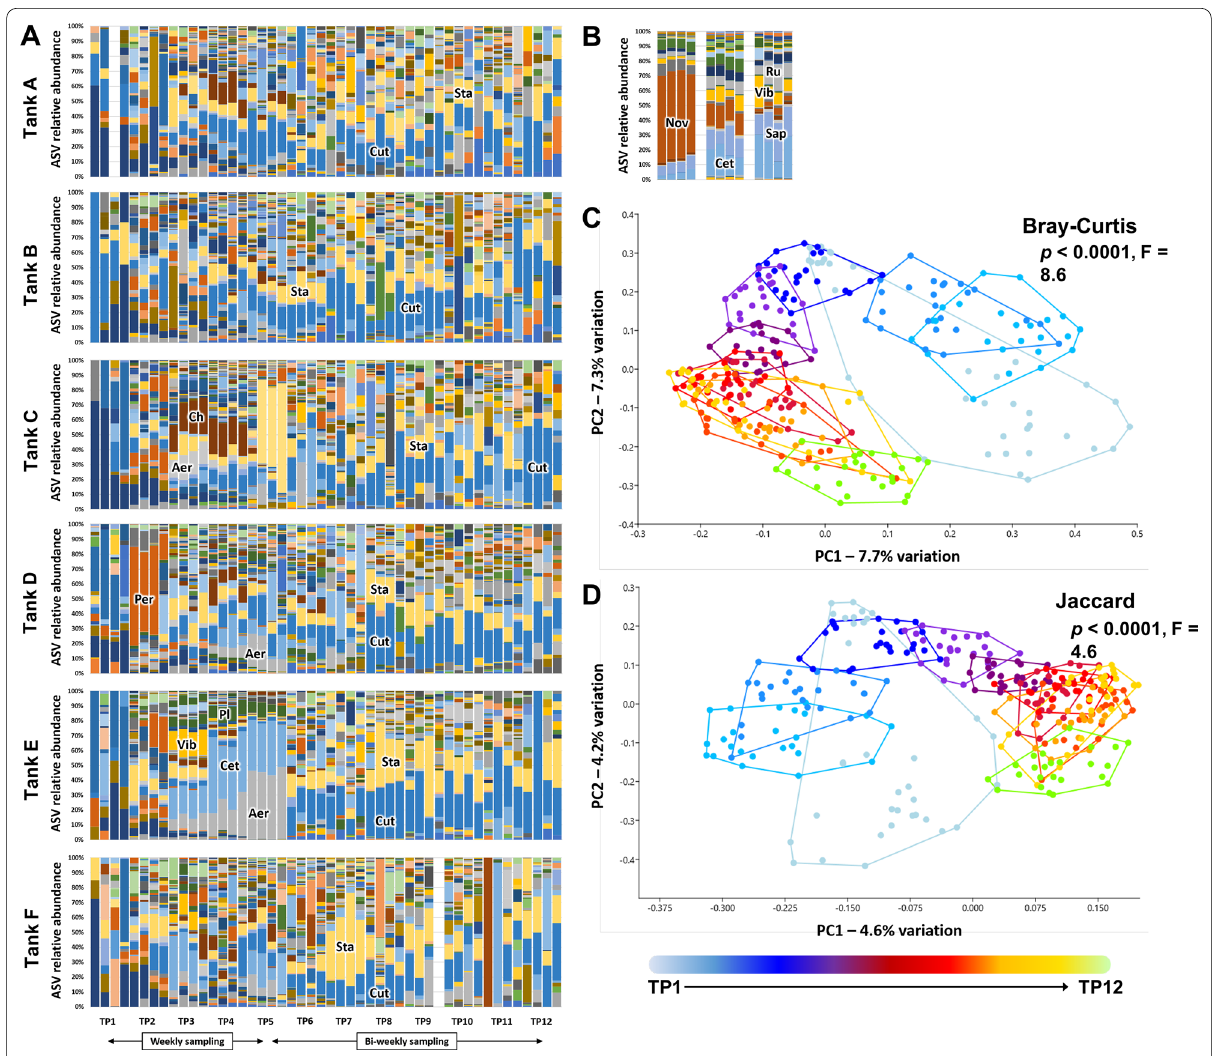
Fig. 3 Dominant taxa in tank water are established by two to three weeks post-population. Stacked bar charts showing the progression in microbiome composition in six tanks (A through F), sampled at 12 time-points (4 replicates/time-point) ( A ) and the pre-existing tanks from which fish originated; ASV amplicon sequence variant, Aer Aeromonas , Cet Cetobacterium , Ch Chitinophagales, Cut Cutibacterium , = = = = = Nov Novosphigobium , Per Perlucidibaca , Pl Plesiomonas , Ru Runella , Sap Saprospiraceae , Sta Staphylococcus , Vib Vibrio ( B ). Principal = = = = = = = coordinate analysis plots based on Bray–Curtis ( C ) and Jaccard ( D ) similarities. TP time-point, color-bar legend at bottom; taxonomic abbreviations = listed at beginning of manuscript. p and F values associated with main effect of time based on one-way permutation multivariate analysis of variance